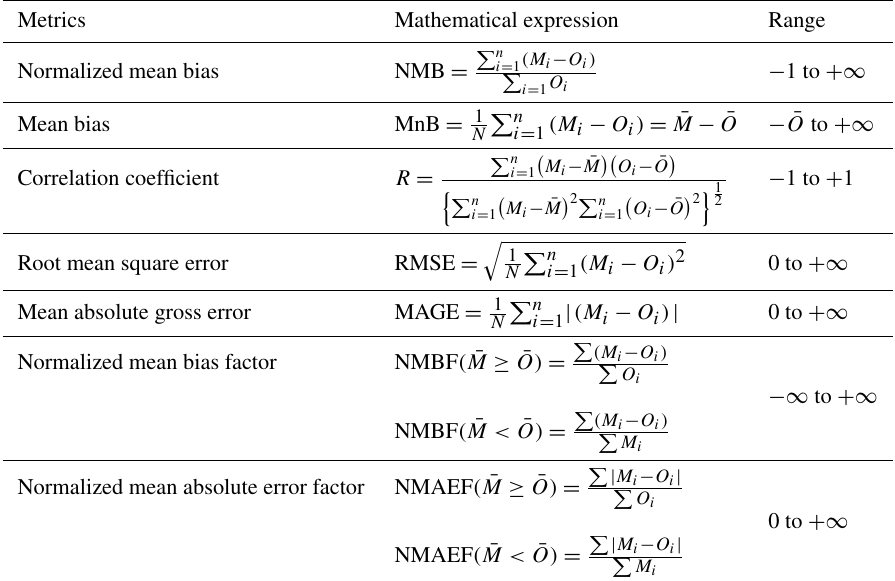
Table 4. Definition of the metrics used to evaluate the ACCMIP model performances. O and M refer to observations and model, respectively. P n P n ¯ O = 1 O i , ¯ M = 1 M i . i = 1 i = 1 N N Metrics Mathematical expression